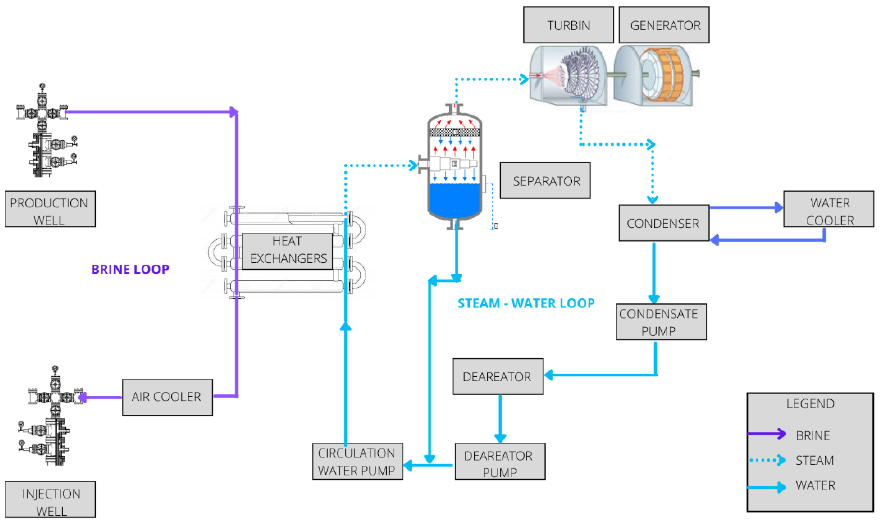
Figure 6. Diagram of the medium flow in the Habanero Pilot Power Installation (based on [14]).